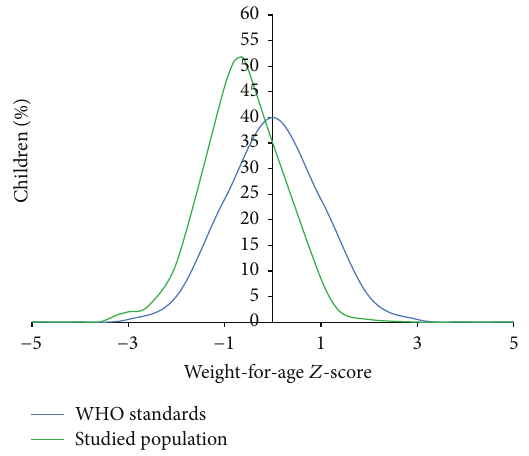
Figure2:Distributionoftheindexweight-for-ageinschoolchildren studied at the beginning of the study compared to the reference population (WHO).